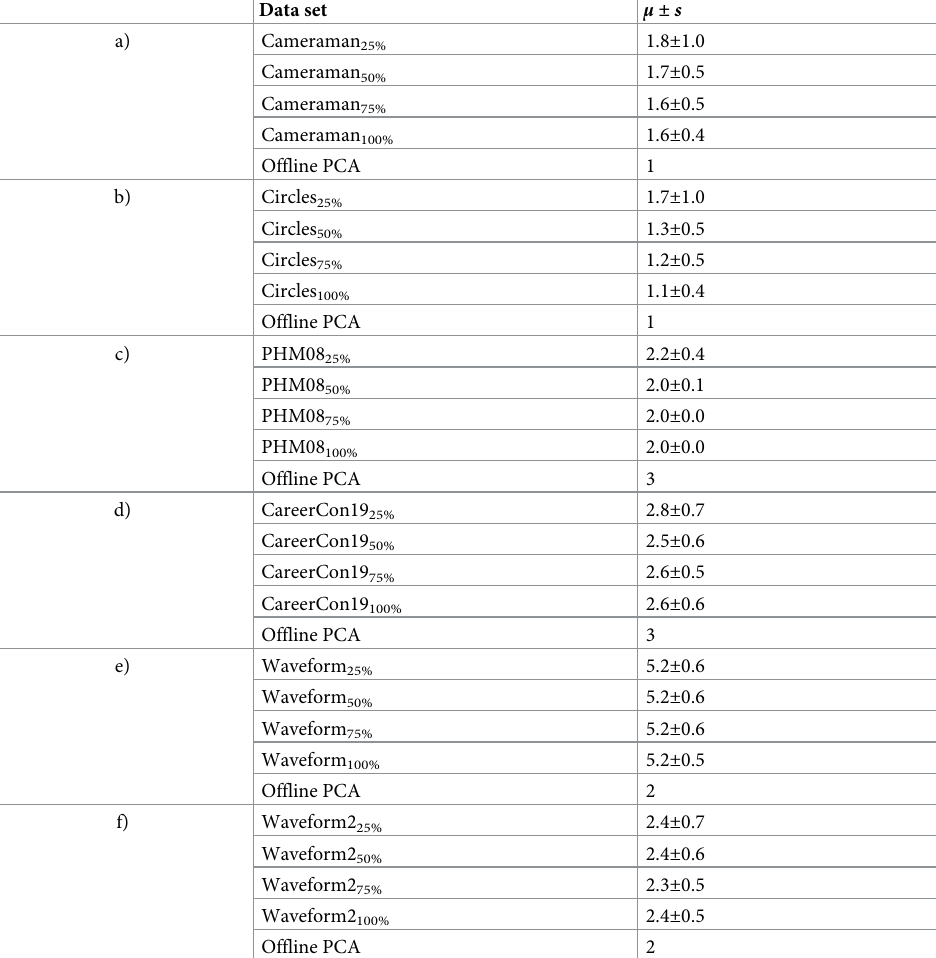
Table 3. Comparison of the online eigenvalue-average criterion with the offline